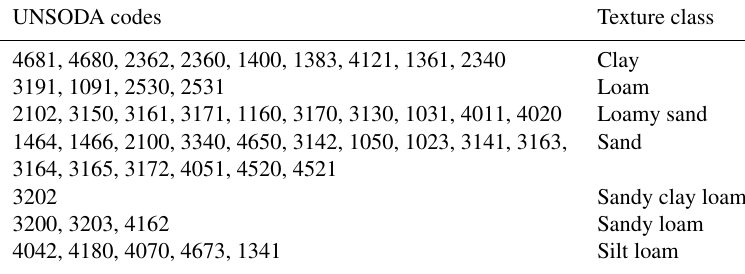
Table 1. Codes and texture classes of the 48 soils selected from UNSODA.